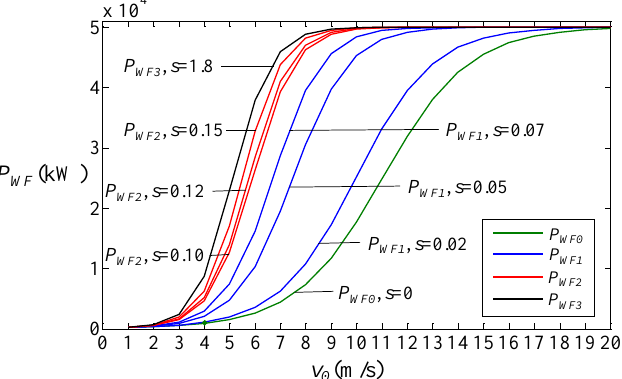
Figure 9. Simulation results of the WF power curve functions with different slopes.